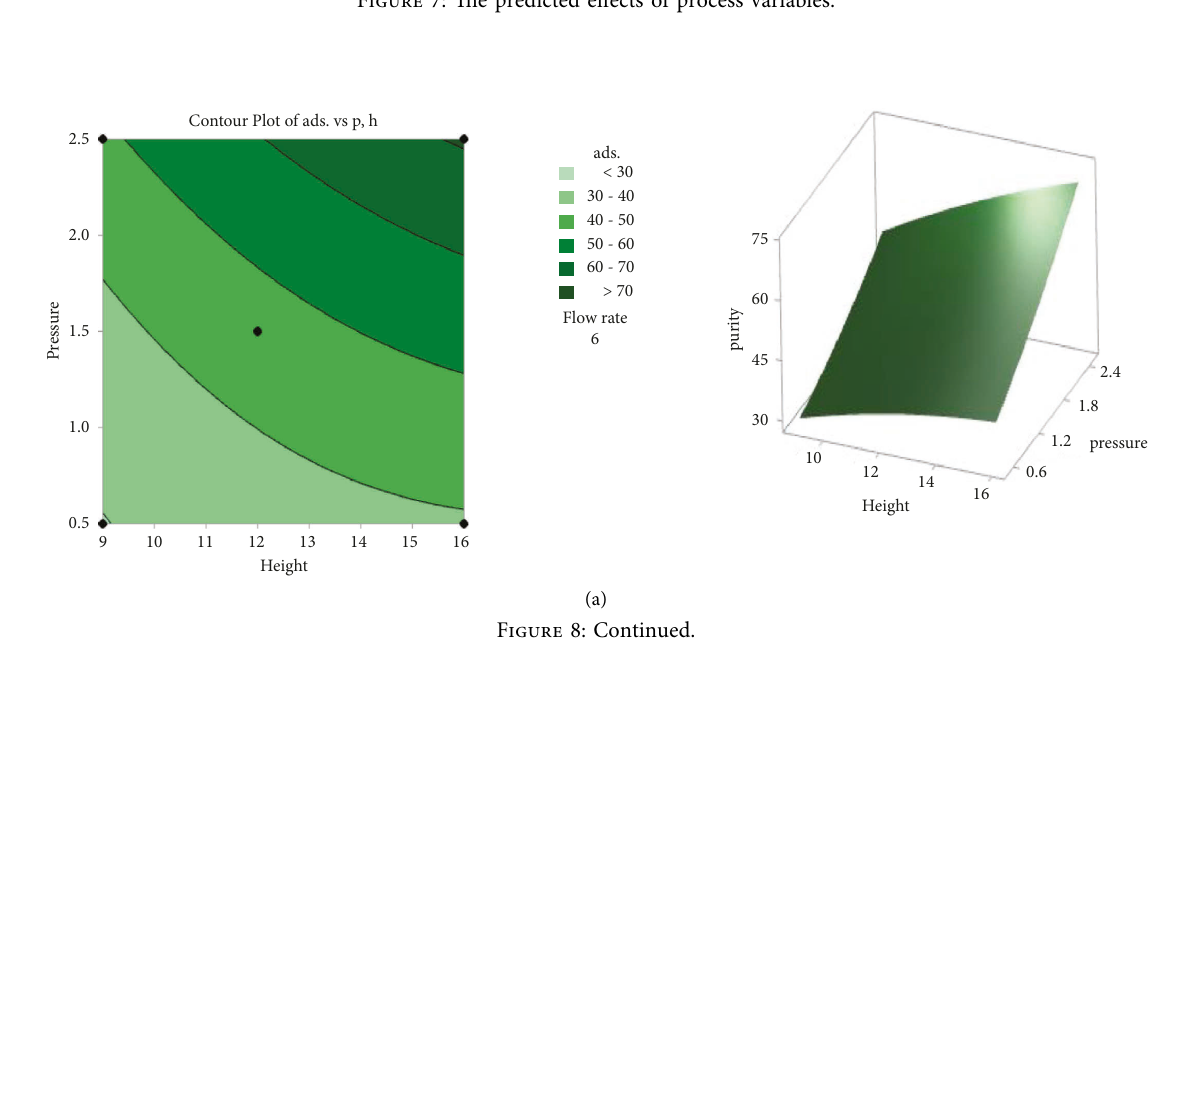
Figure 7: The predicted effects of process variables.